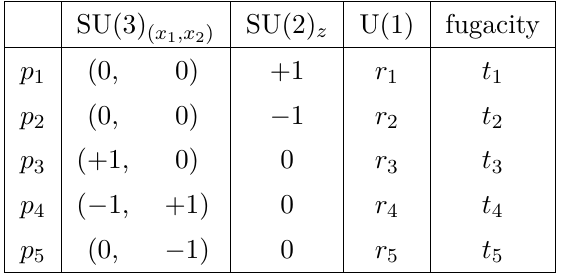
Table 9 . Global symmetry charges on the extremal brick matchings p i of Model